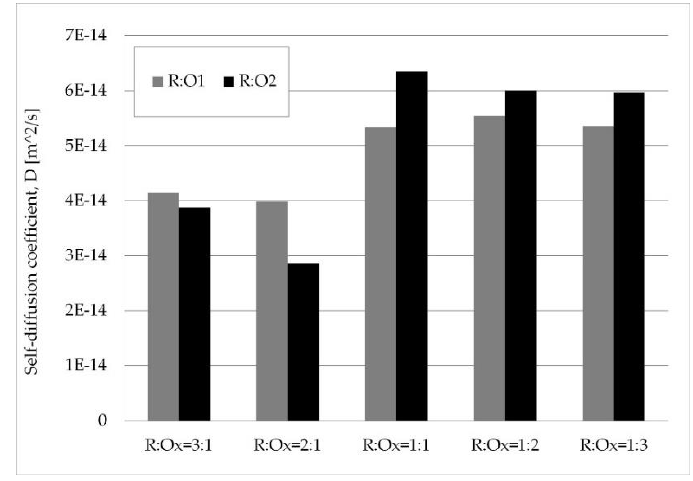
Figure 2. S elf-diffusion coefficients (D) of the bitumen extenders. Figure 2. Self-di ff usion coe ffi cients (D) of the bitumen